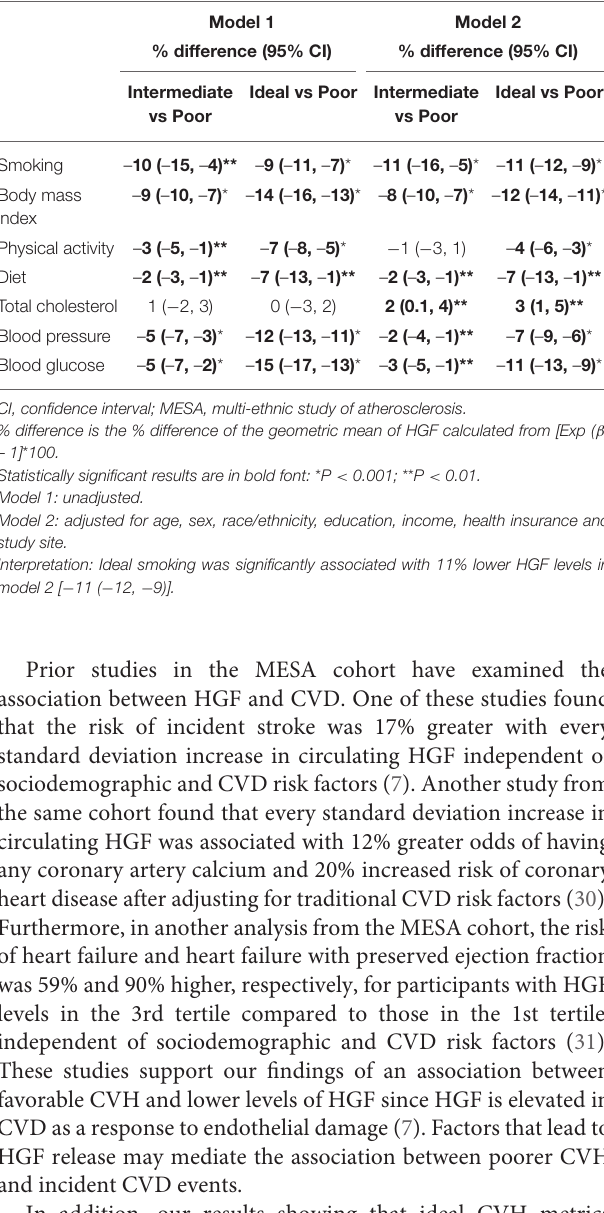
TABLE 3 | Associations between the cardiovascular health metrics and hepatocyte growth factor in MESA (2000–2002), N =